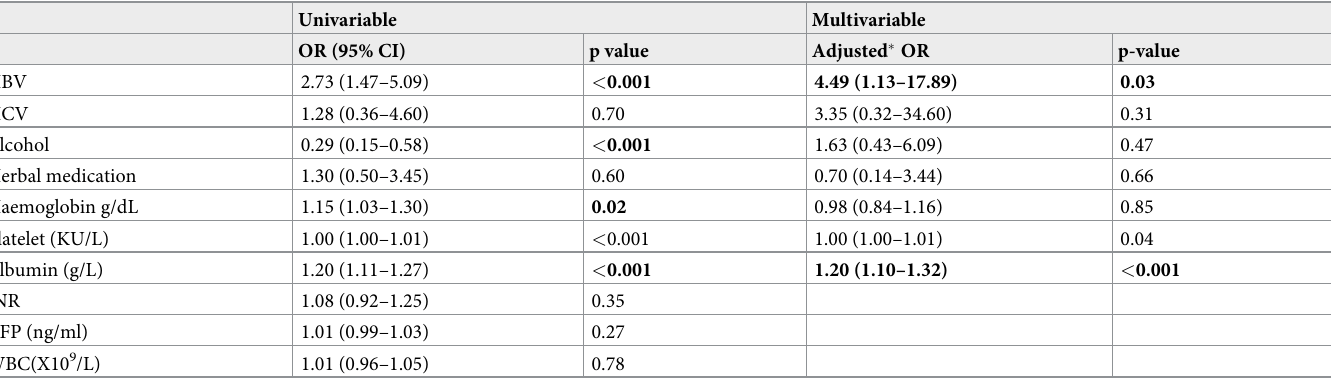
Table 2. Logistic regression analysis of clinical variables associated with HCC (outcome) compared with cirrhosis in patients admitted to a tertiary referral